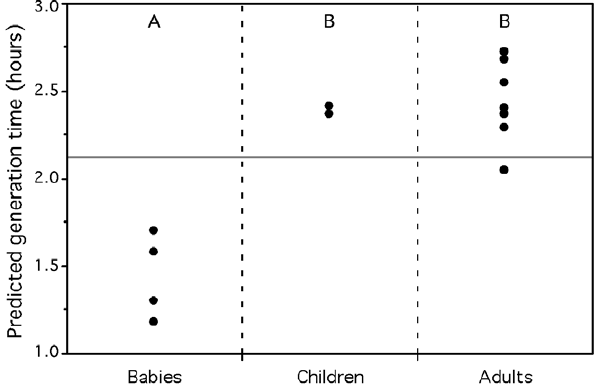
Figure 8. Average predicted minimum generation time for the gut metagenomes of humans of different age groups. Un- weaned babies are 3, 4, 6, and 7 months old. Weaned children are 1.5 and 3 years old. Adults are between 24 and 45 years old. Groups not connected by the same letter (A or B) are significantly different (Tukey- Kramer: p-value , 0.005). The full horizontal line represents the average of the predictions for all individuals.